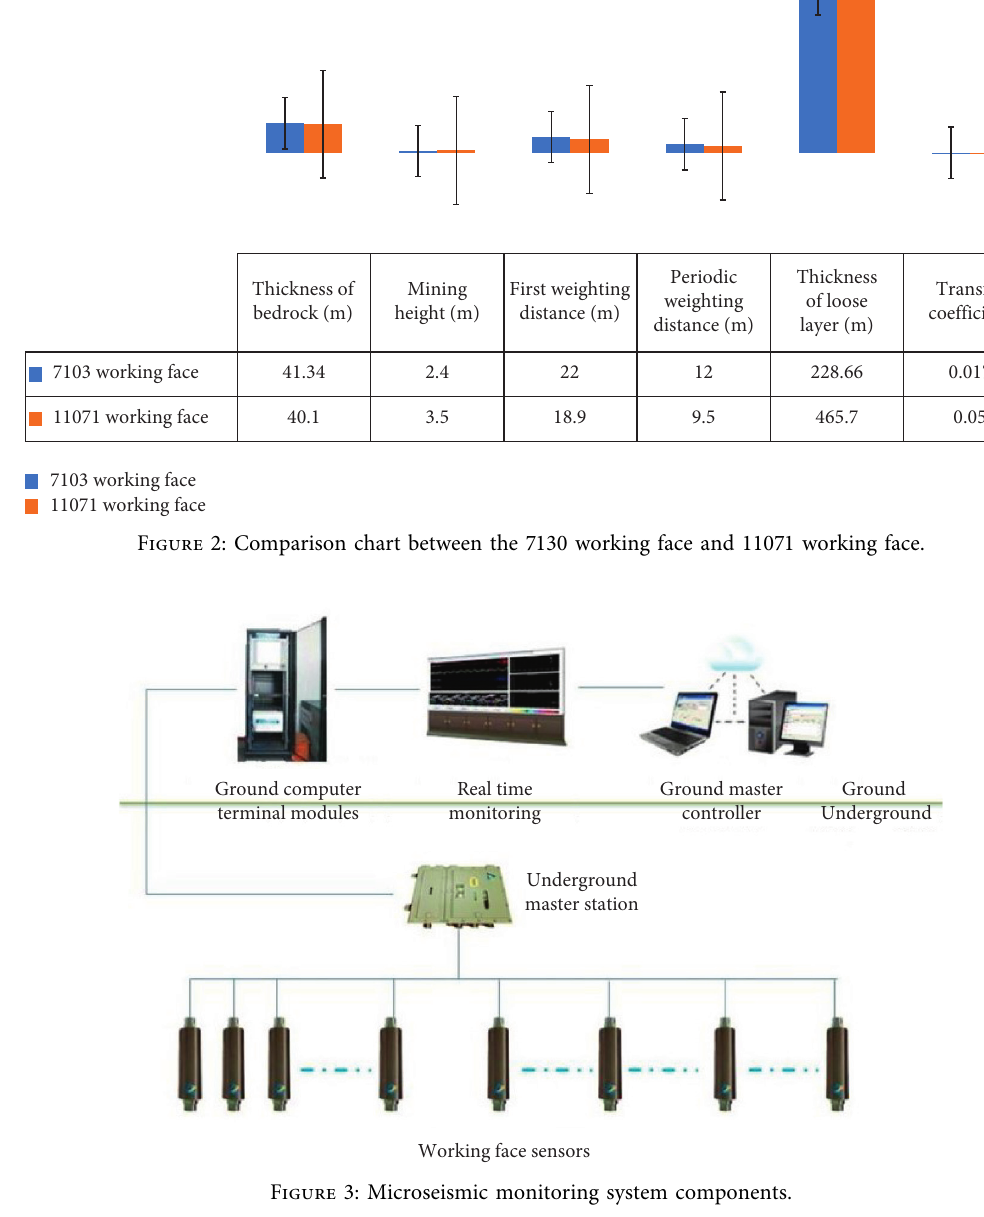
Figure 3: Microseismic monitoring system